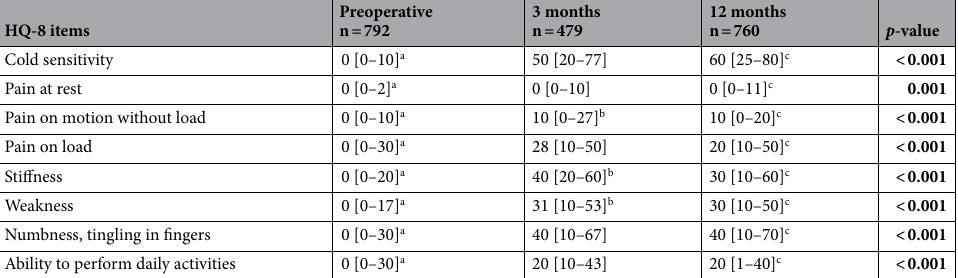
Table 2. HAKIR questionnaire 8 (HQ-8) results in 1553 individuals with digital nerve injury treated with suture. Data are presented as median [IQR; interquartile range]. Significance testing with Kruskal–Wallis and post-hoc Mann–Whitney U-test were used. *Bold values indicate p -value < 0.05. a indicates p < 0.05 between preoperative and 3 months postoperative values; b indicates p < 0.05 between 3 months postoperative and 12 months postoperative; c indicates p < 0.05 between preoperative and 12 months postoperative. *Due to the low number of same responders for all three questionnaires, paired analyses were not applicable